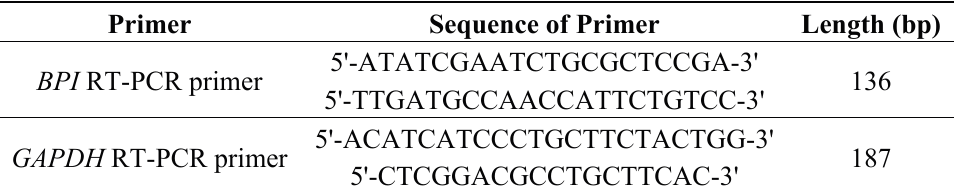
Table 3. RT-PCR (real-time PCR)